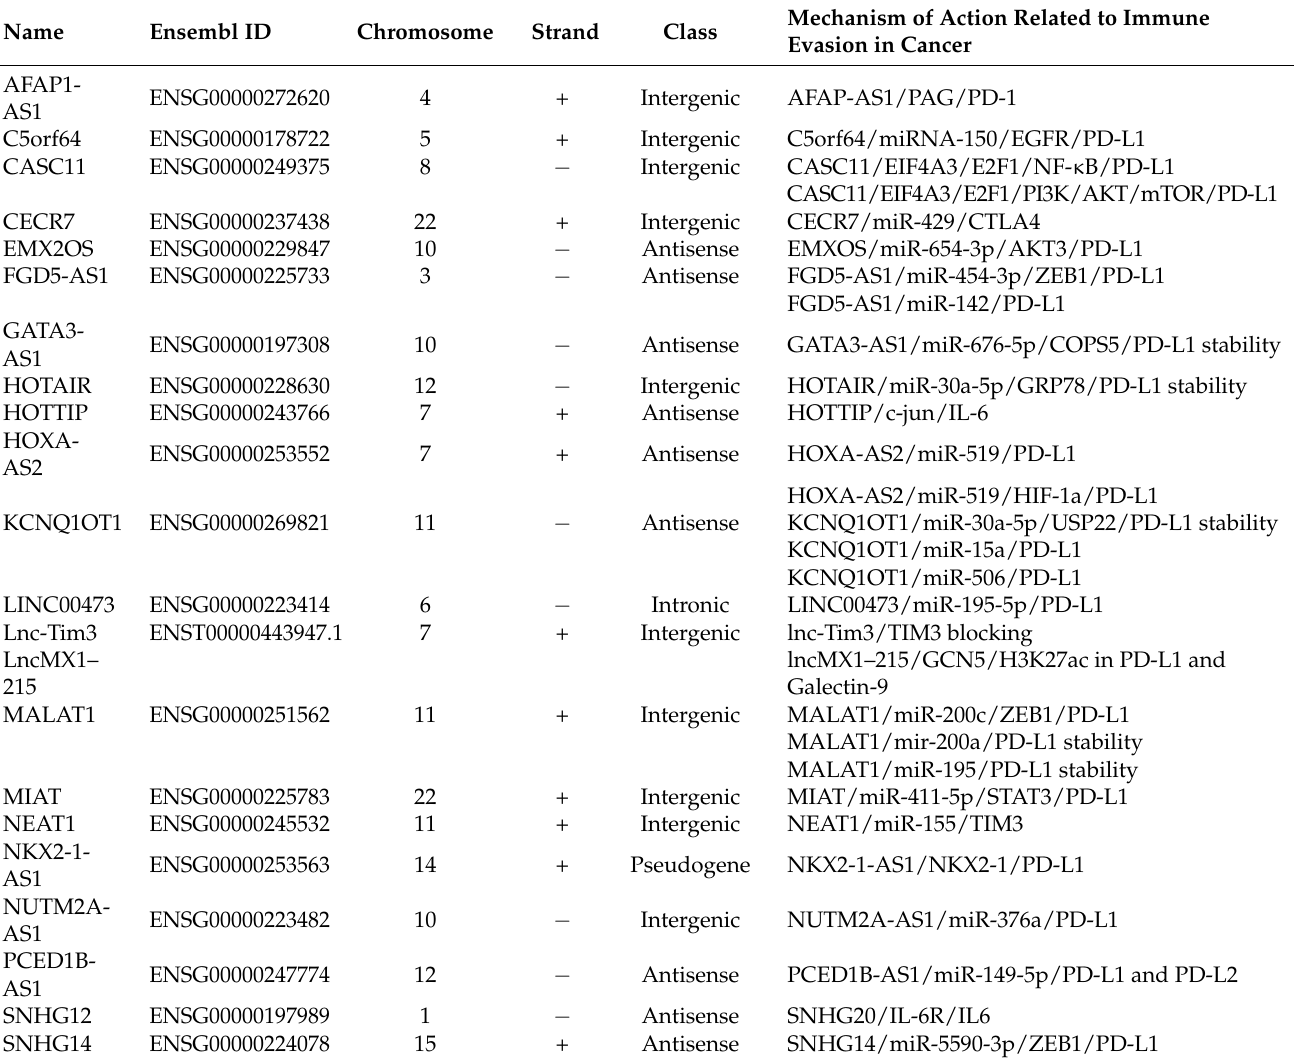
Table 3. LncRNAs related to immune evasion in cancer. The last column summarizes the regulatory pathways detailed in the